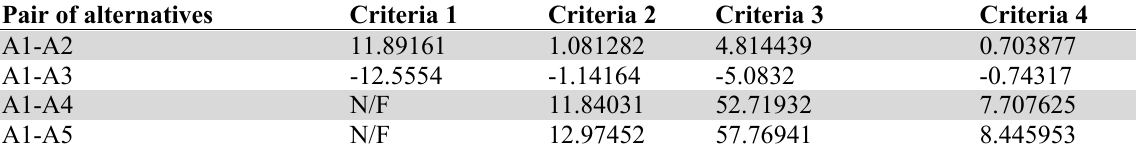
Threshold values Ʈ′ in relative terms for the first alternative (percentage values) (cid:1809),(cid:1810),(cid:1811) Pair of alternatives